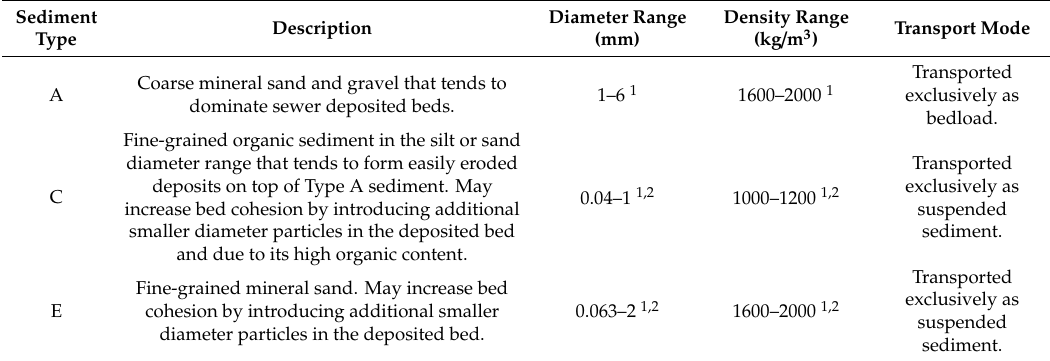
Table 1. Description, likely characteristics, and transport method of the three sediment fractions implemented in SewerSedFoam